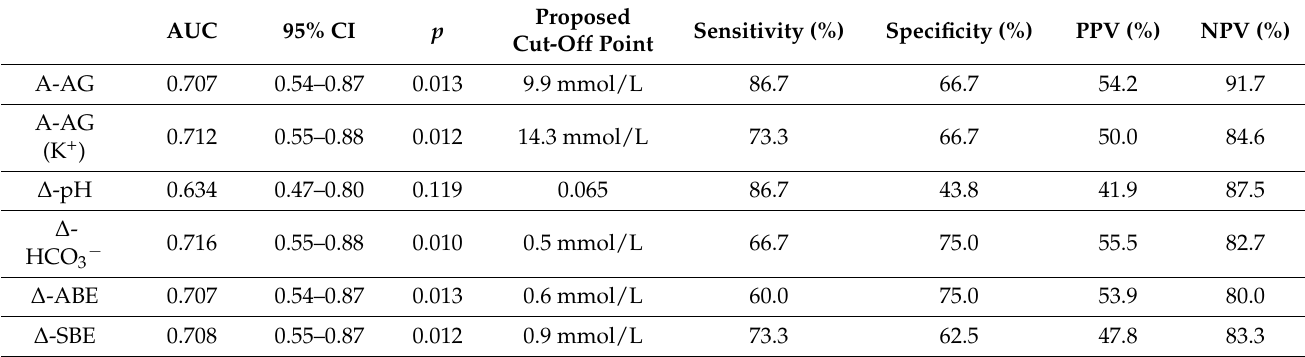
Table 4. Discriminative power of different acid-base indices for diagnosis eGFR < 10 mL/min/1.73 m 2 . AUC 95%